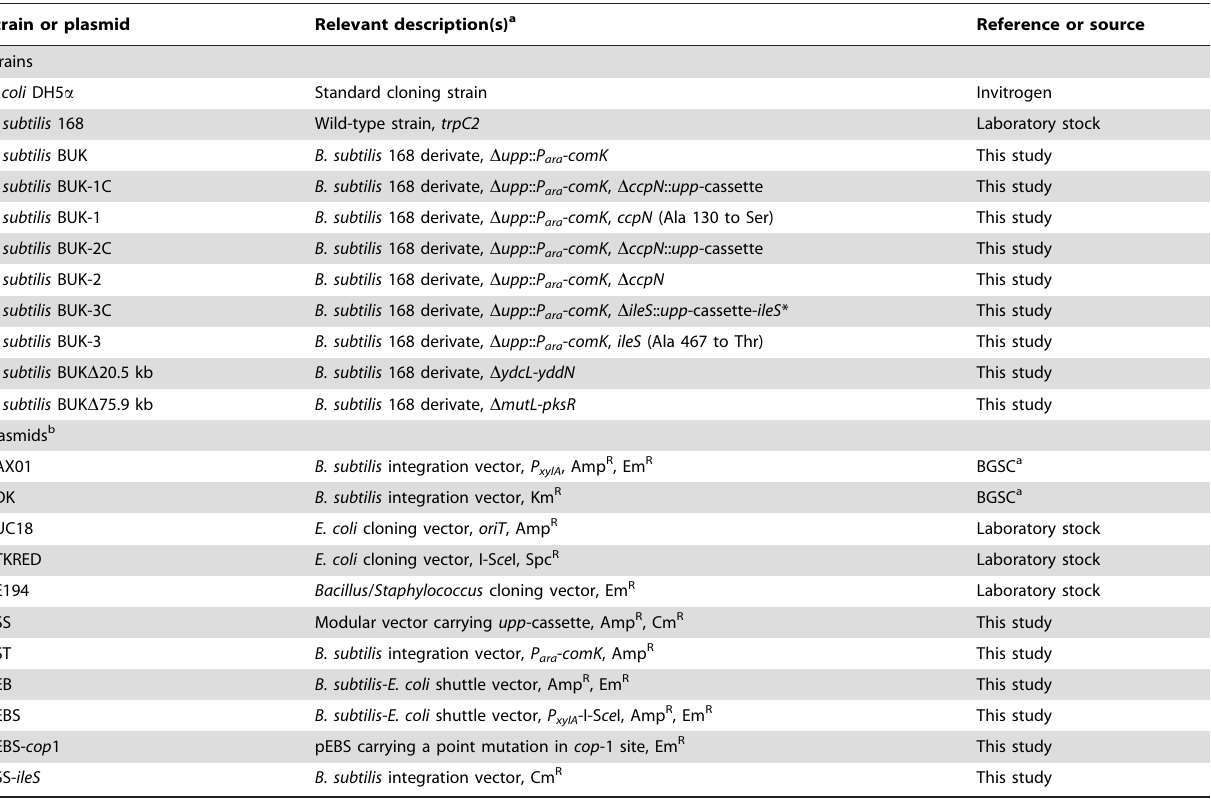
Strain or plasmid